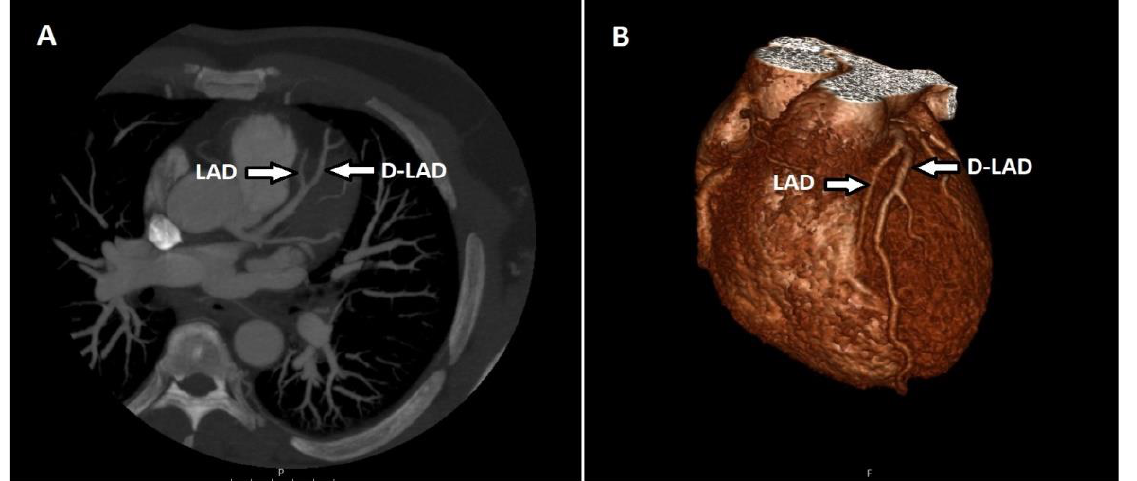
Figure 4. Maximum-intensity projection (MIP) of axial CT ( A ) and volume-rendered (VR) ( B ) image shows the LAD terminating above the atrioventricular groove and the duplicated LAD (D-LAD) extending distally along the groove.